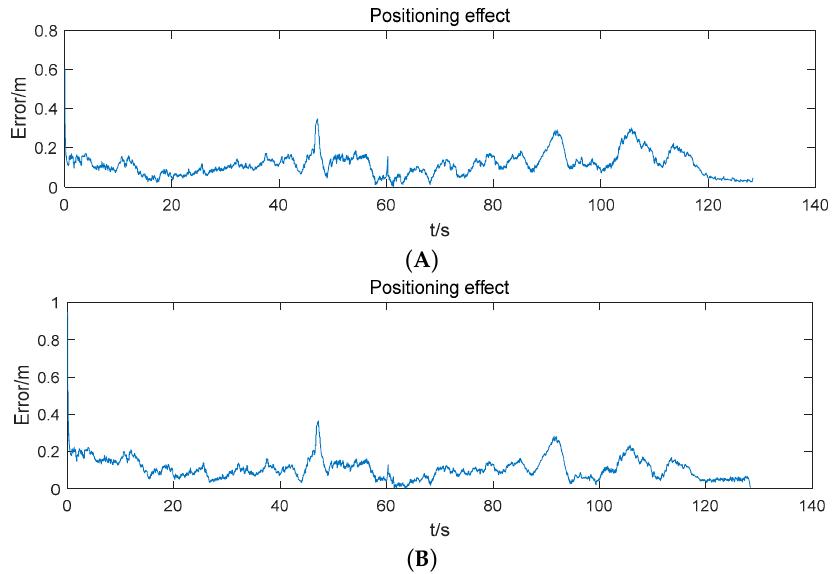
Figure 11. Positioning effect of the positioning system. ( A ) Using the estimation position of the new anchor. ( B ) Using the reference position of the new anchor.